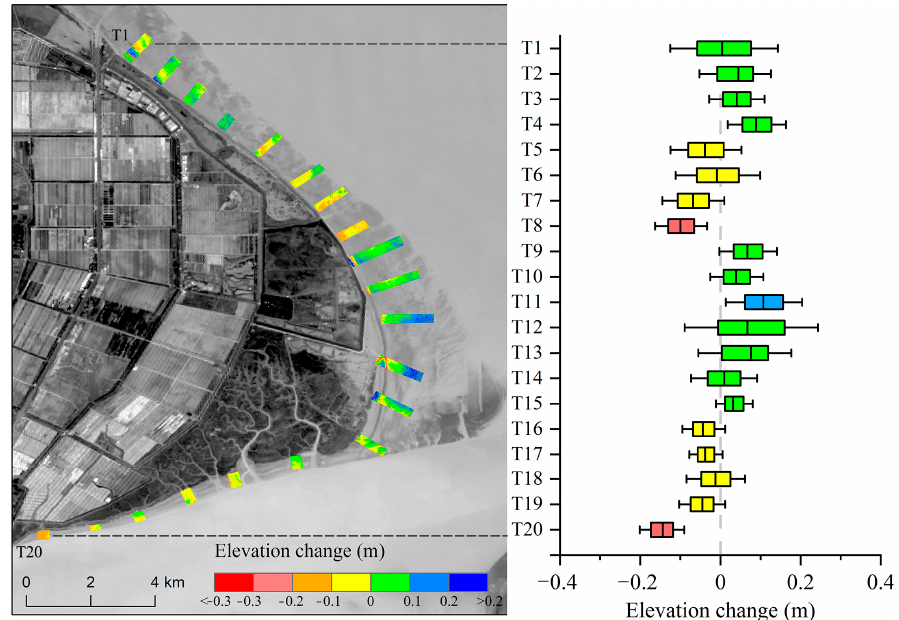
Figure 8. The patterns of accretion and erosion in the CDNR and the average annual